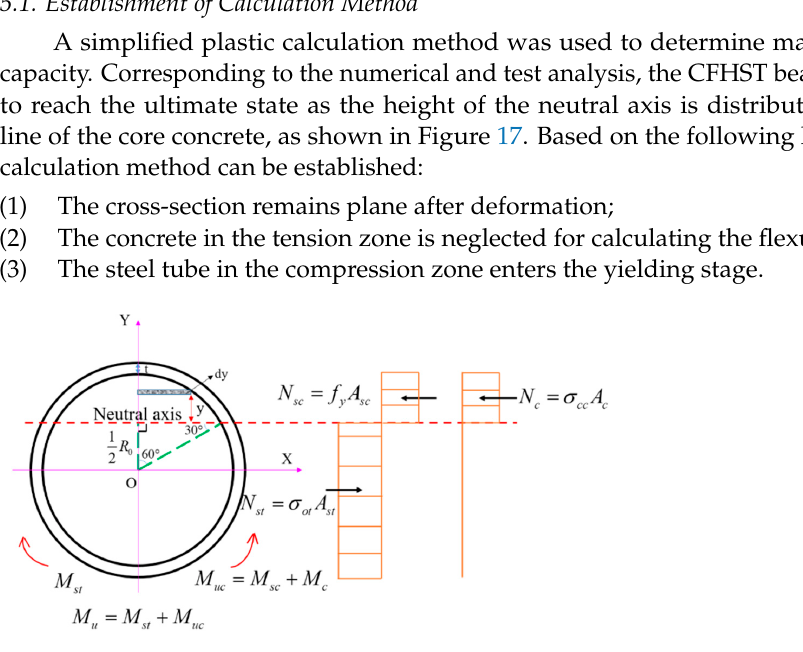
Figure 17. Stress distribution at the mid ‐ span section.